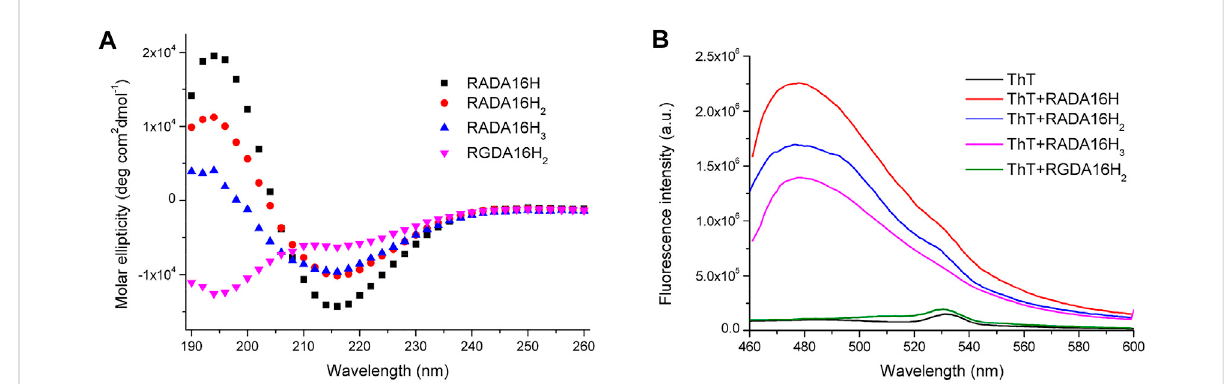
FIGURE 2 (A) CD spectrum of 75 μ M RADA16H, RADA16H 2 , RADA16H 3 , and RGDA16H 2 dissolved in water. CD signals were collected at 25 ° C. Peptides RADA16H, RADA16H